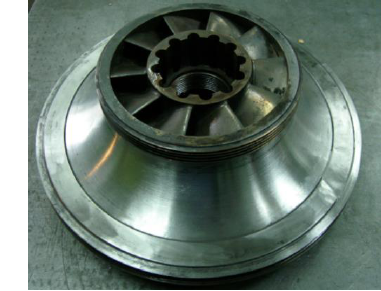
Figure 9. The manufactured rotor